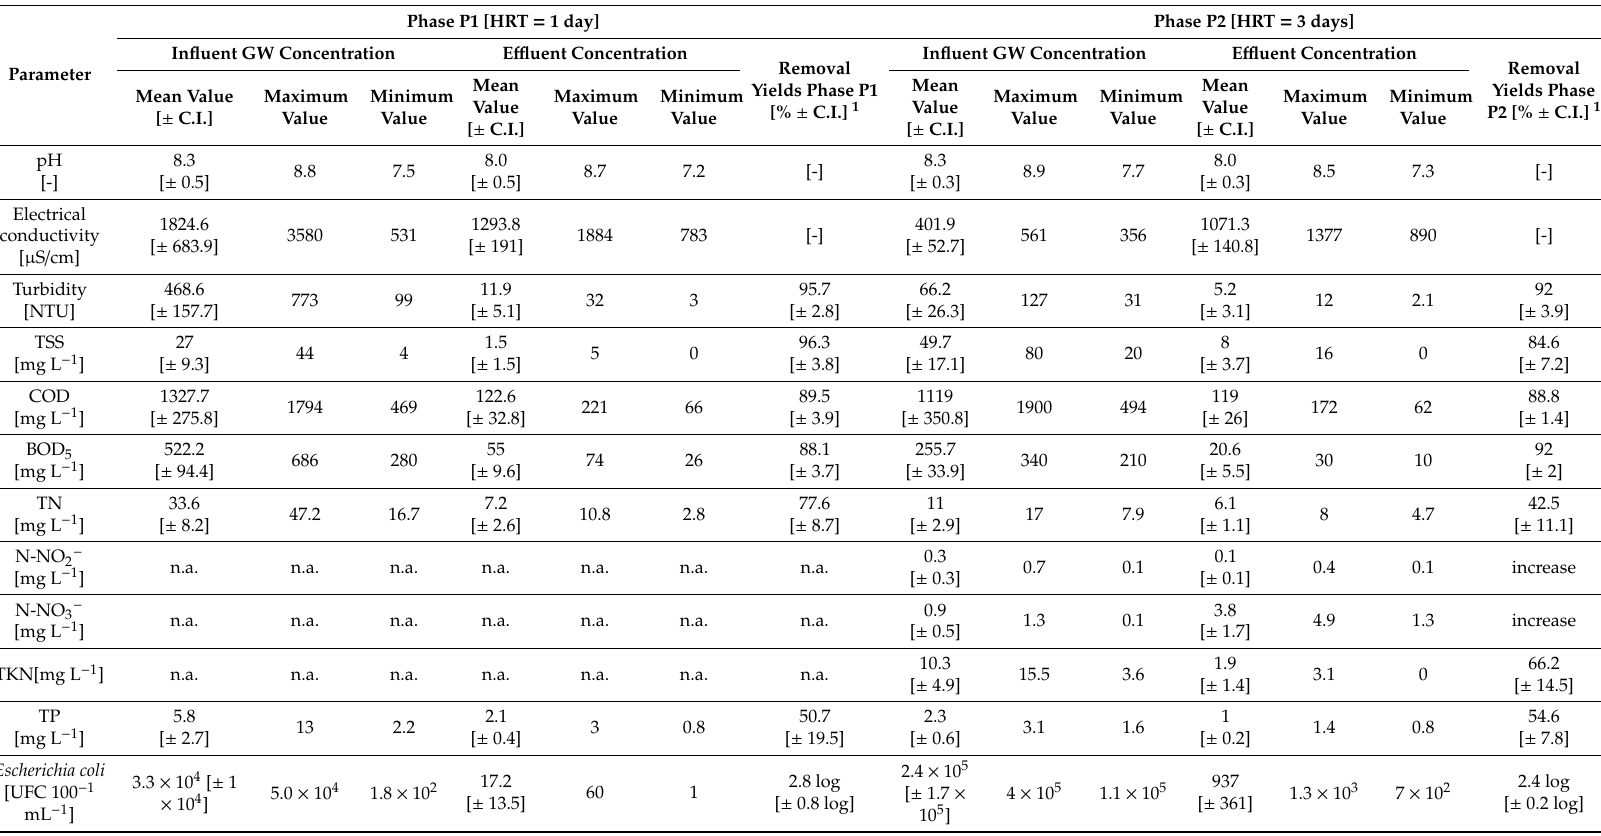
Table 2. Overall statistics of influent GW and e ffl uent concentrations in the pilot-scale plant (phase P1 and P2) and removal yields of pollutants.